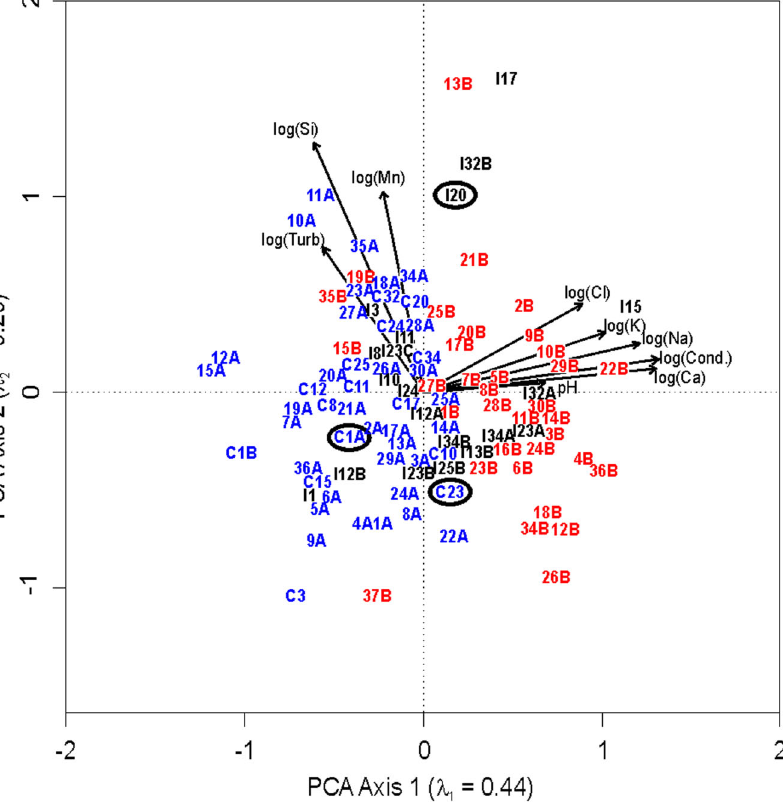
Figure 3. Principal components analysis (PCA) ordination of select chemical variables in the 101 lake dataset. Black labels represent the position of the drilling-sump lakes in the ordination space (n=20). Red labels represent lakes impacted by retrogressive thaw slumping (n=34). Blue labels represent control lake ordination results (n=47). Variables were all normalized using log transformation. Arrows represent importance of given chemical variables in structuring the distribution of sites. Ordination results of study lakes I20, C23, and C1A, from which sediment cores were analyzed, are circled. Si = reactive silica.